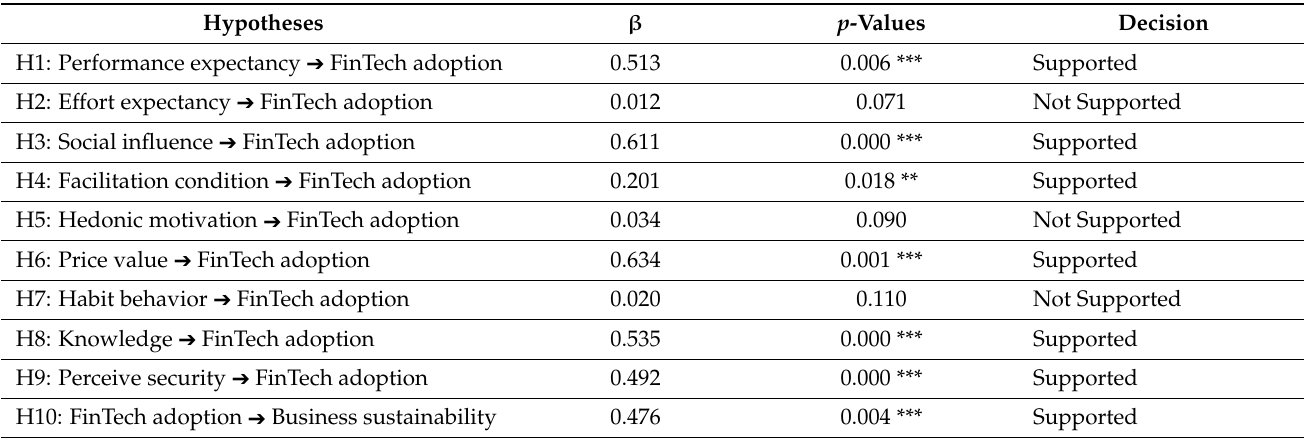
Table 5. Hypothesis testing.